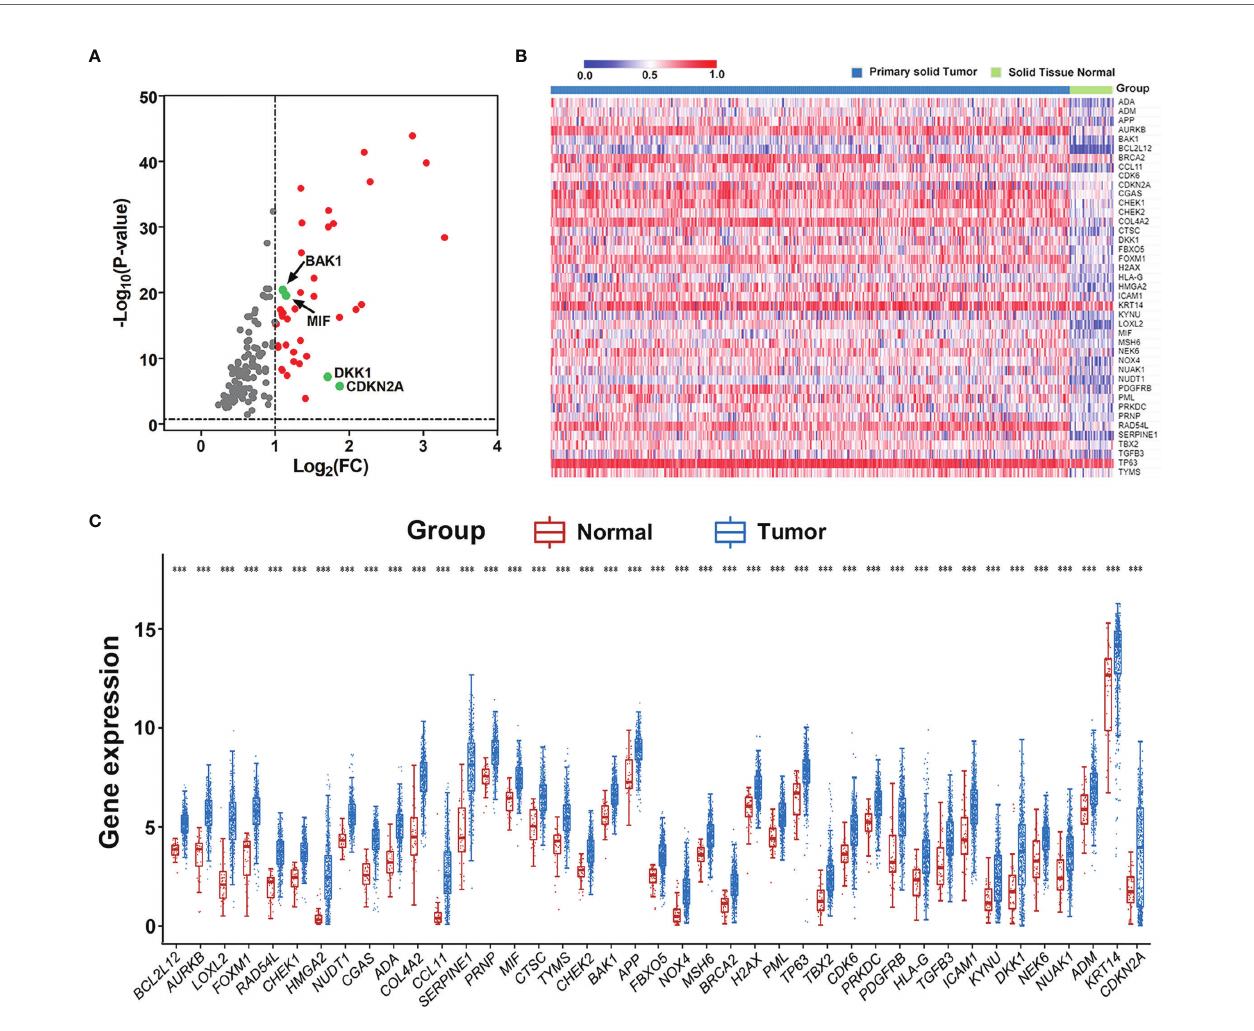
FIGURE 1 | Extraction of differentially expressed aging-related genes (AGs) based on TCGA datasets. (A) Volcano plot for the 134 AGs in HNSCC retrieved from GSEA based on TCGA datasets. FC represents fold change. Red indicates upregulation, gray indicates no difference, and the studied four genes are marked in green. (B) Heat map of the 41 differentially expressed AGs in HNSCC. (C) Expression distribution of differentially expressed AGs in HNSCC and normal tissue samples. The red dot represents normal tissue sample, and the blue dot represents tumor sample. *** p <